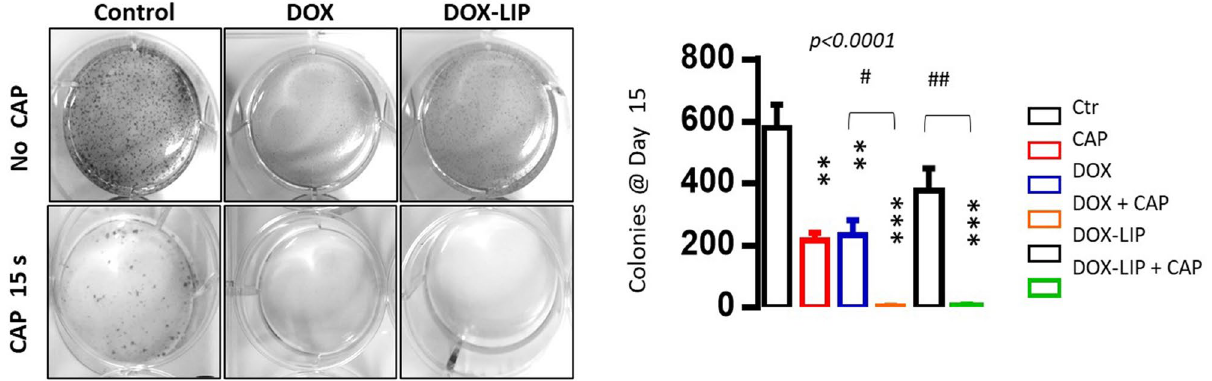
Figure 5. Effect of CAP exposure and/ or DOX treatment on colony formation capability by B16 melanoma cells. ( a ) Representative colonies are shown after 15 s CAP exposure or/and 0.1μΜ DOX treatment, free or liposomal. ( b ) Colony numbers counted after 15 d. Results are the mean ± standard deviation of three individual studies. * p < 0.05 or ** p < 0.01 vs. control group under indicated culture